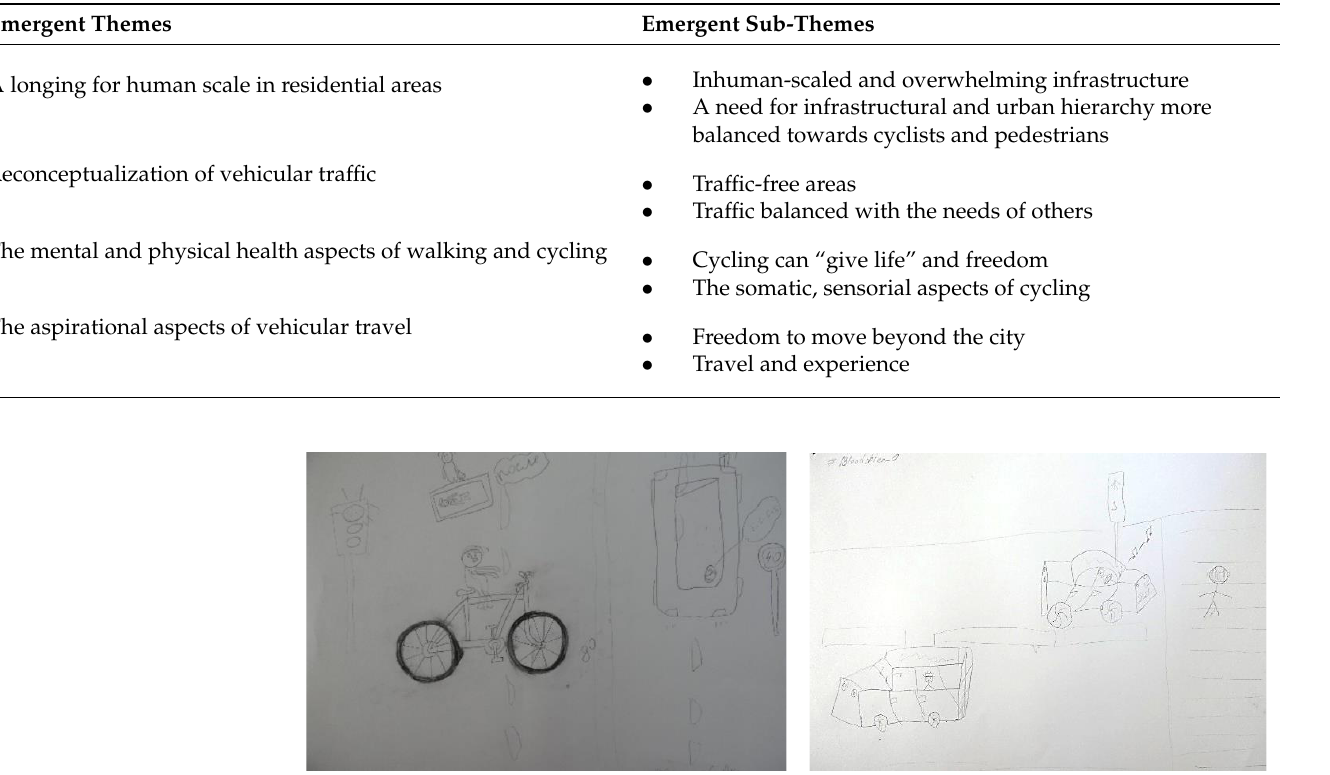
Table 3. Content Analysis of Participants’ Drawings from 2021 and 2022 Workshops